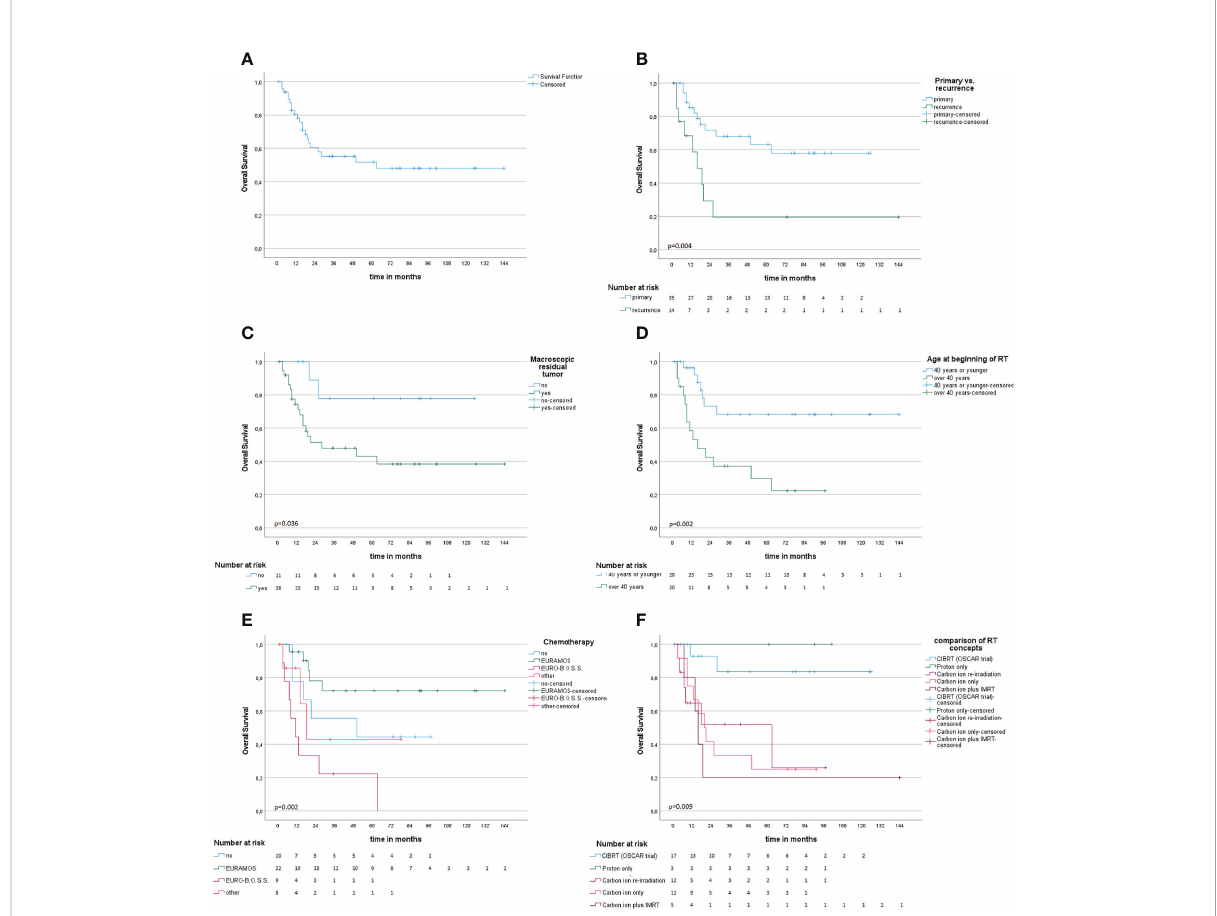
FIGURE 2 Kaplan – Meier survival analysis (A) and univariate subgroup analysis (B – F) . (A) Overall survival probability. (B) Radiotherapy at the time of primary diagnosis compared to recurrent disease is associated with improved survival. (C, D) Macroscopic residual tumor on MRI or CT and age above 40 years at beginning of RT are associated with impaired OS. (E) Comparison of different chemotherapy concepts. (F) Comparison of different concepts of particle